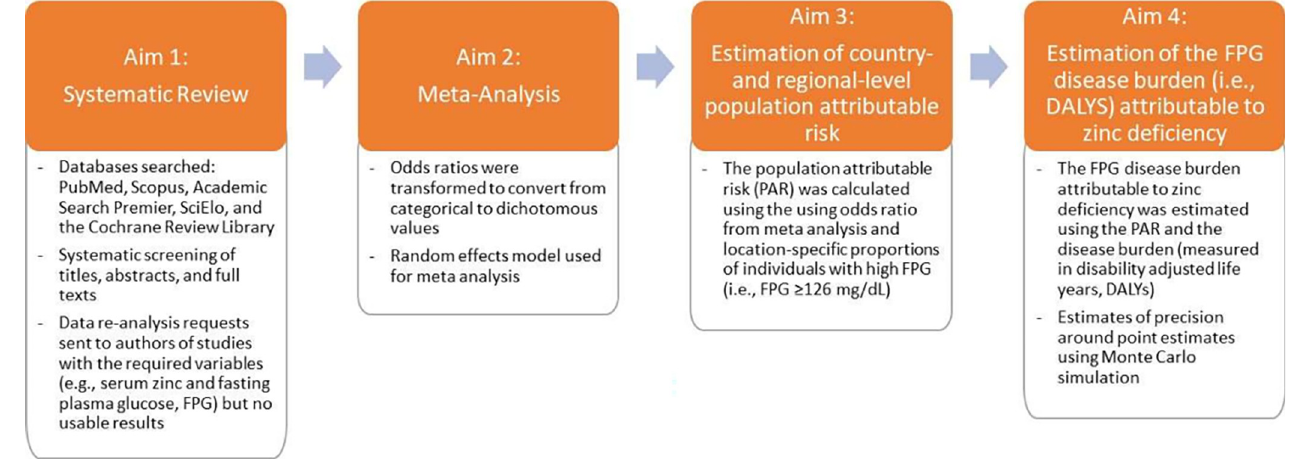
Fig 1. Analytical phases of the research